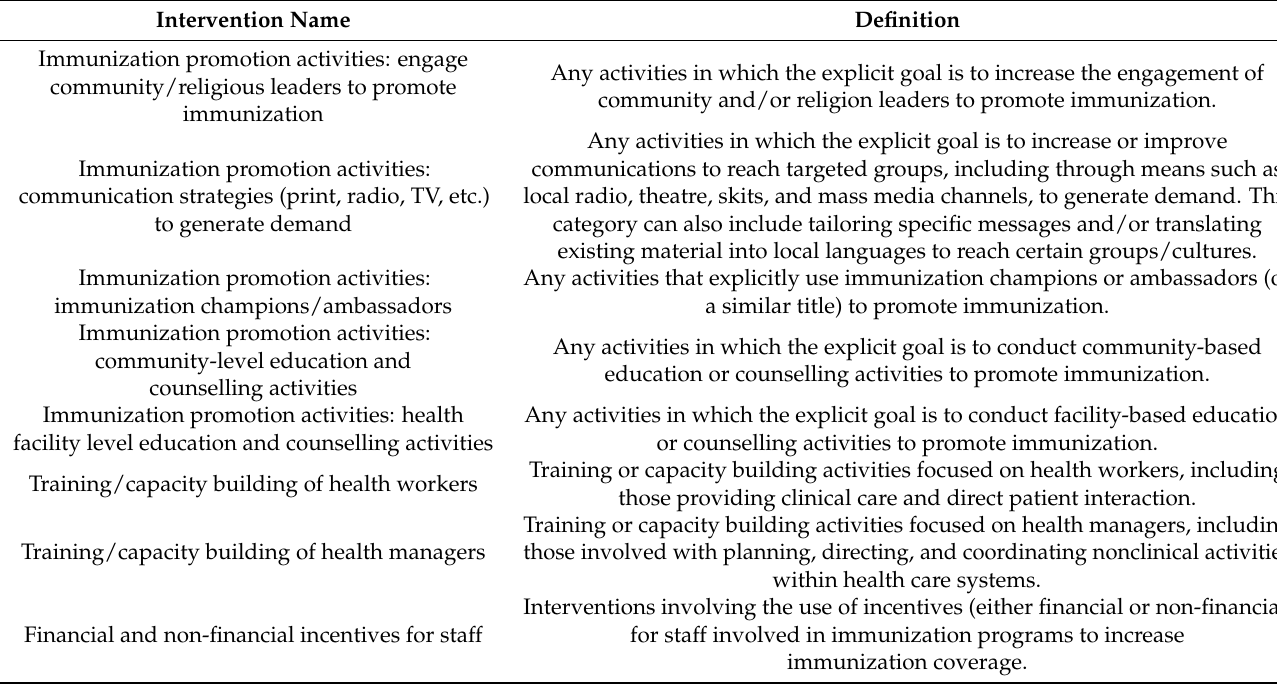
Table A1. List of all pro-equity intervention categories found in HSS proposals relating to